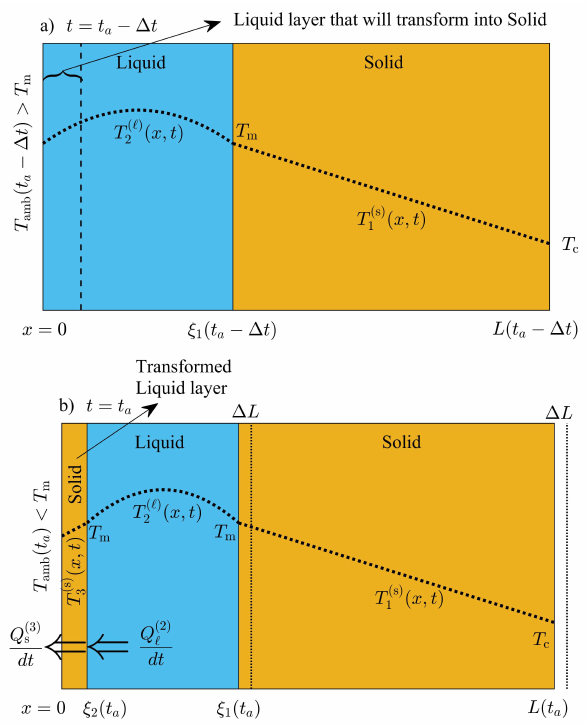
Figure 3. Solid phase formation close to the exterior surface produced by the change of the ambient temperature from T amb ( t a − ∆ t ) > T m to T amb ( t a ) < T m during a small time interval ∆ t . ( a ) Thin liquid layer that will change to its solid phase. The layer is still in its liquid form at t = t a − ∆ t , when the temperature on the exterior surface is just above the melting temperature of the PCM. ( b ) Volume shrinkage ∆ L = L ( t a − ∆ t ) − L ( t a ) produced by the shift of the interior surface, after the liquid layer in contact with the exterior surface is transformed into its solid